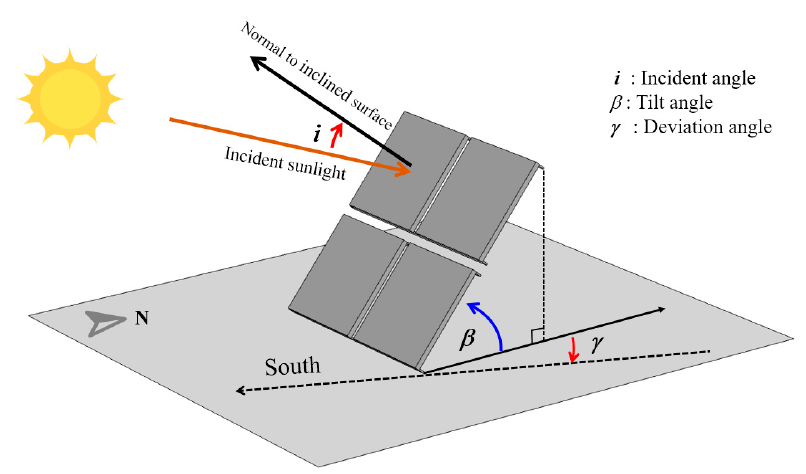
Figure 2. Schematic diagram of the solar angle.